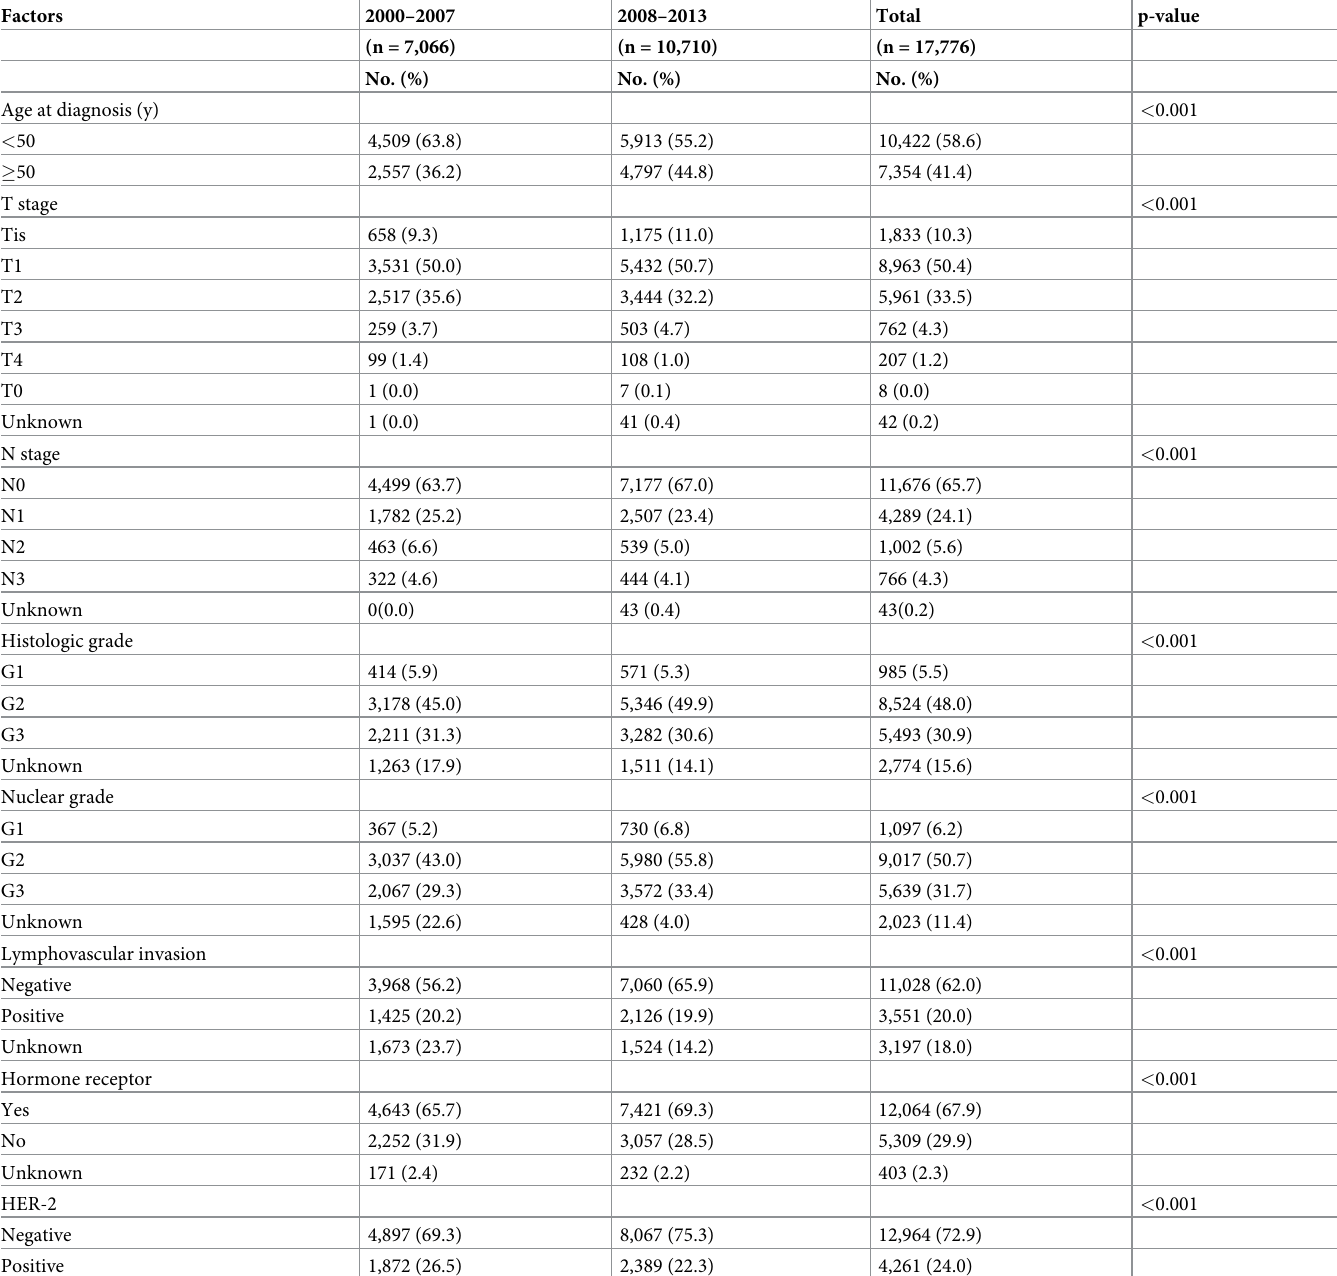
Table 1. Clinicopathological characteristics of patients according to the period at